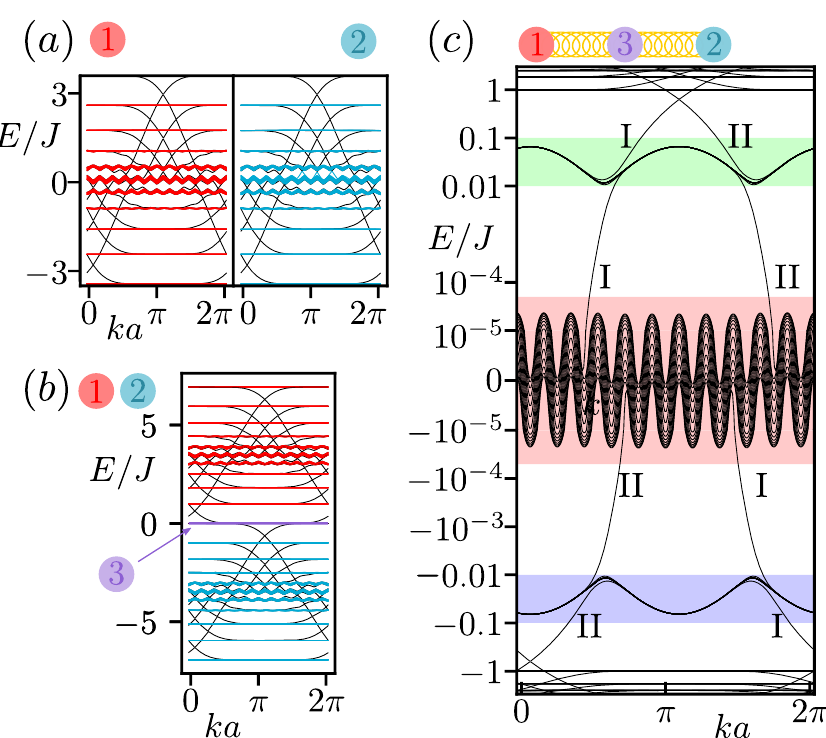
Figure 2: Designing a Λ system from two Hofstadter bands and a trivial flat band. ( a ) Hofstadter bands associated with two uncoupled atomic internal states ( σ = 1,2), for a flux φ = 1 / 11. The black dispersions correspond to edge-state branches [ 65 ] ; the system is diagonalized on a cylindrical geometry. (b) Adjusting the detunings δ σ in ˆ H Λ such that two Hofstadter bands (populated by states σ = 1,2) become degen- = 0. erate with a flat trivial band (populated by σ = 3) in the uncoupled limit A 1,2 (cid:54) = 0, max | Ω ( k ) | = J / 5) splits the three overlap- (c) Activating the coupling ( A 1,2 1,2 ping bands into a flat dark band at zero energy (red shaded), and two bright bands (green / purple shaded). The flatness of the dark band is emphasized by a logarithmic scale. The edge-state branches, associated with the two edges (I,II) of the cylinder, = indicate that the Chern number of the dark band is C D